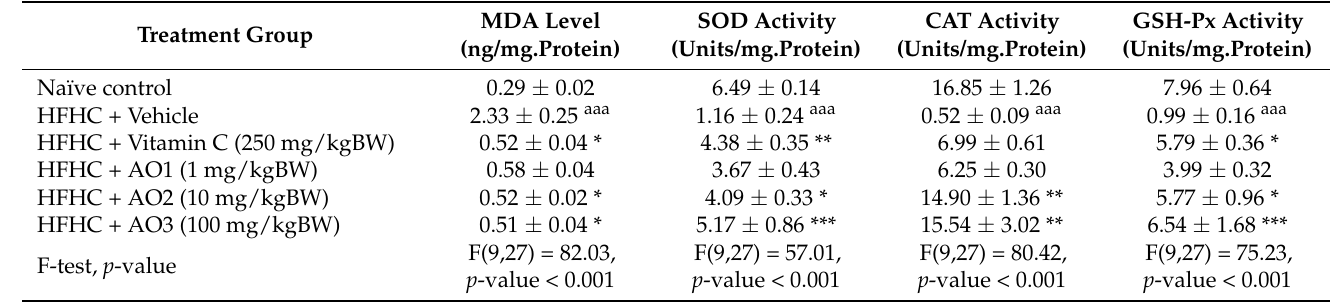
Table 6. Oxidative stress markers including malondialdehyde (MDA) level, and the activities of main endogenous antioxidant enzymes such as superoxide dismutase (SOD), catalase (CAT), and glutathione peroxides (GSH-Px) in